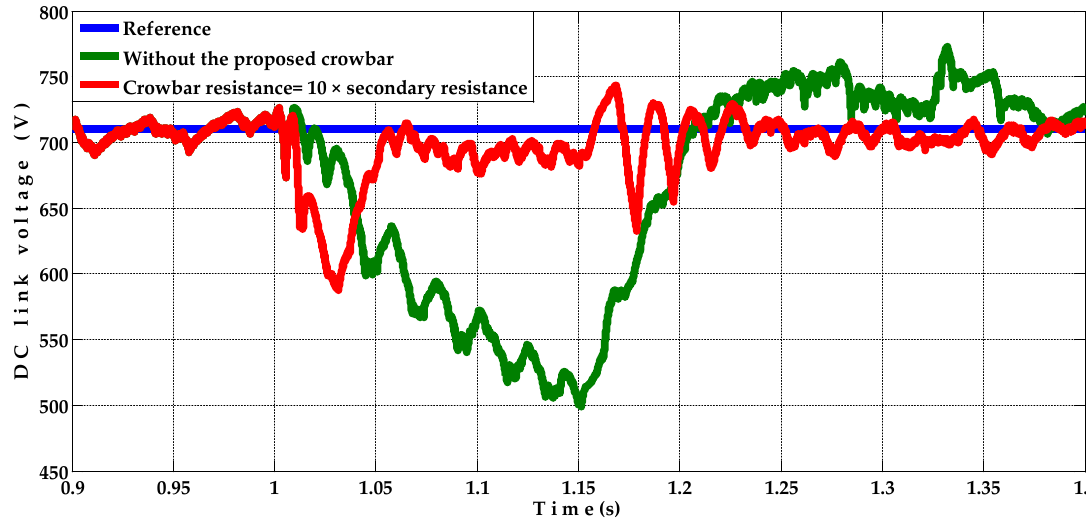
Figure 12. DC link voltage of BDFRG with and without the proposed crowbar under symmetrical fault occurrence.